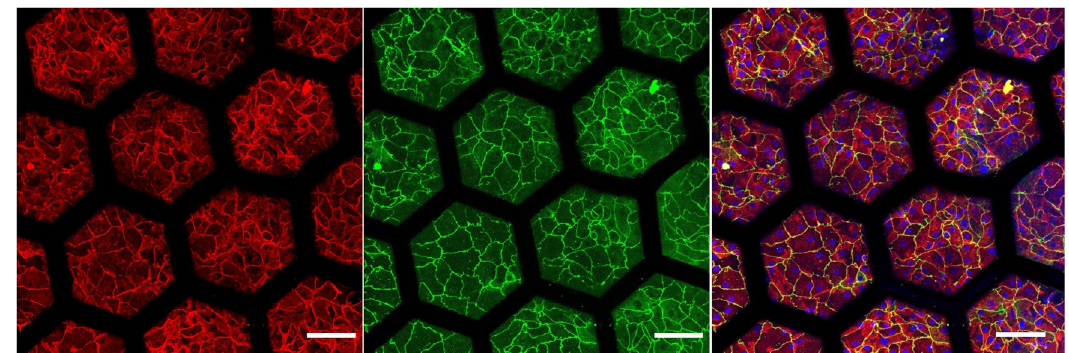
Fig. 4 Immunostaining of primary human lung alveolar epithelial cells. hAEpC cultured on the hexagonal mesh with the CE membrane after 4 days and at air – liquid interface for 2 days with expression of adherent junction markers (E-Cadherin, red), tight junctions with zonula occludens-1 (ZO-1, green) and merged (Hoechst, blue; E-Cadherin, red; ZO-1, green). Scale bar: 100